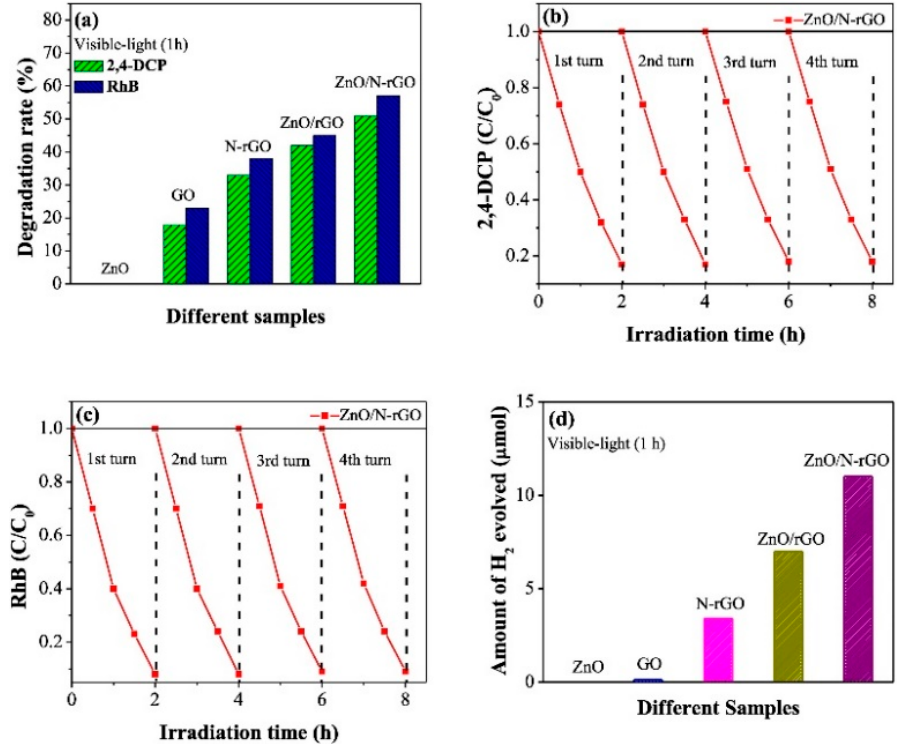
Figure 29. Visible-light activity of ZnO, GO, N-rGO, ZnO/rGO, and ZnO/N-rGO samples for 2,4-dichlorophenol and RhB degradation ( a ), stability and recyclability tests ( b ) of 2,4-dichlorophenol degradation and ( c ) of RhB over ZnO/N-rGO. Amount of H2 evolved over ZnO, GO, N-rGO, ZnO/rGO, and ZnO/N-rGO ( d ). Schematic for charge transfer and separation and the photocatalytic process over ZnO/N-rGO composite. Reprinted with permission from [158].